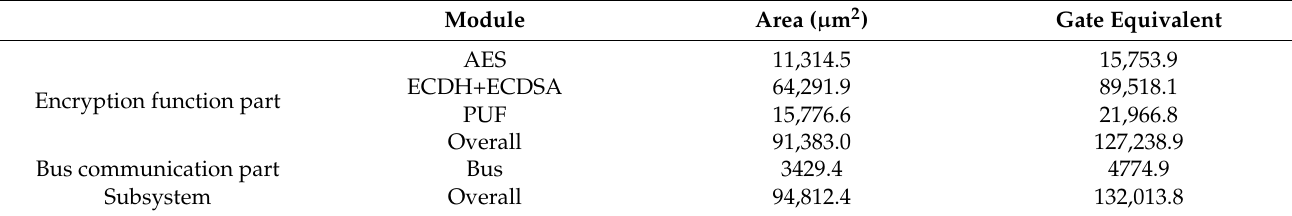
Table 1. Image encryption subsystem resource usage results under ASIC implementation.